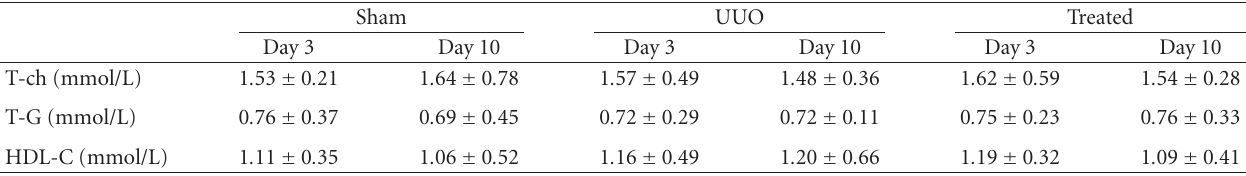
Table 1: Serum lipid level at di ff erent time points of di ff erent